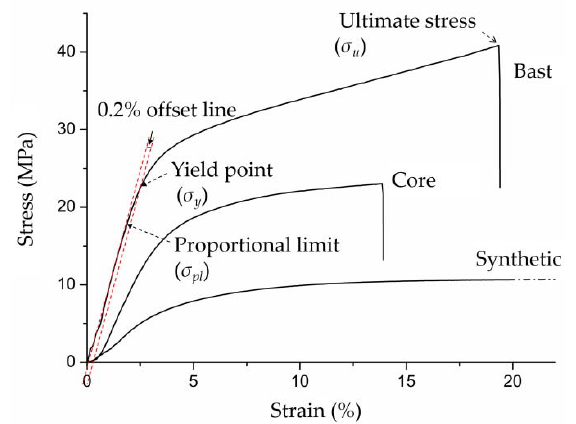
Figure 9. Typical stress-strain curves of natural bast, core, and synthetic rattan strips subjected to tensile loading. Table 3. Mean values of tensile strength and modulus elasticity (MOE) of rattan strips evaluated in test 1 and their mean comparisons for rattan type 1 .